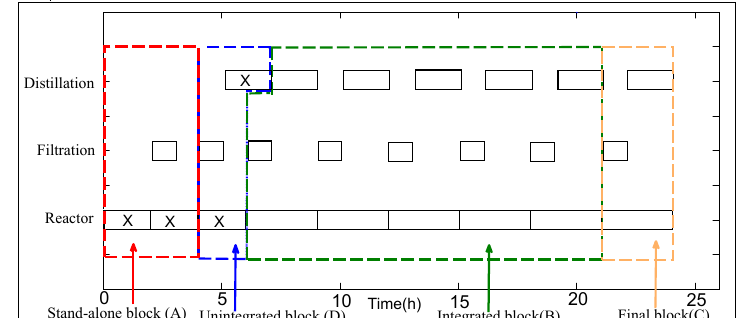
Figure 6. Optimal schedule for BR-S system for 24 h horizon.